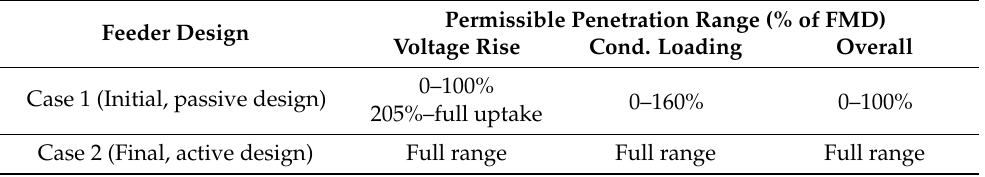
Table 5. Feeder performance analysis for different impact